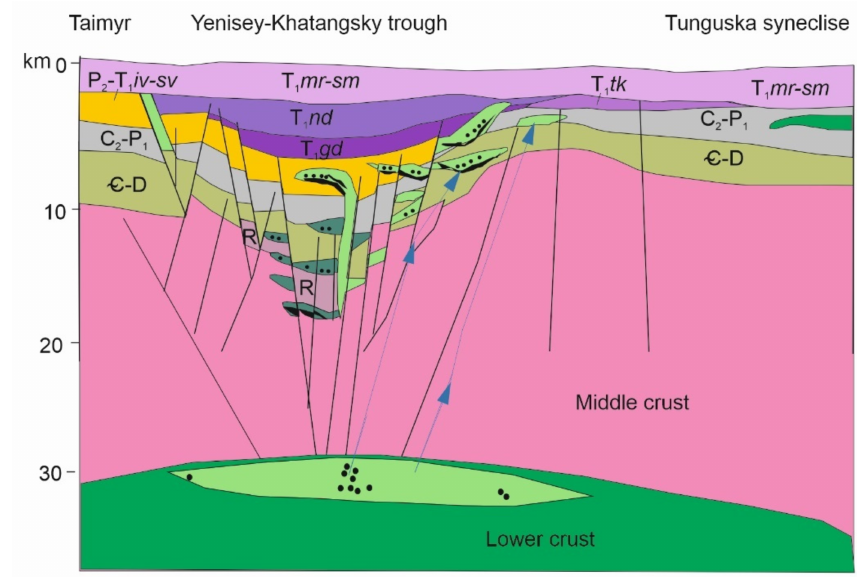
Figure 16. Formation schema for the intrusions of the Norilsk intrusive complex. The black points and lenses are sulfide ores in the intrusions of the Norilsk complex (light green). Sedimentary